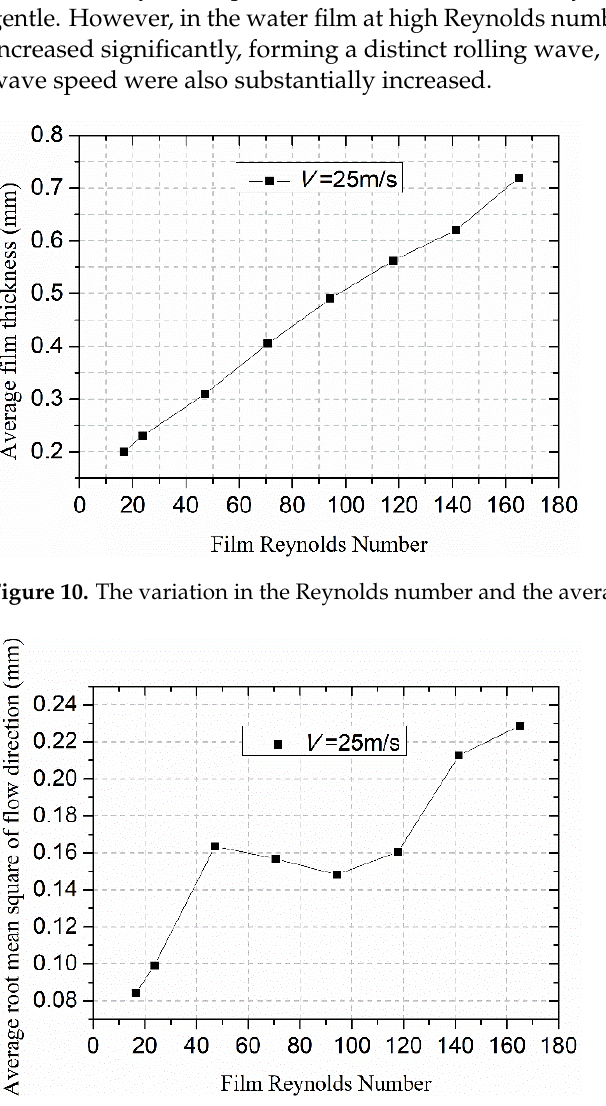
Figure 11. The variation in the Reynolds number of the water film and RMS f .